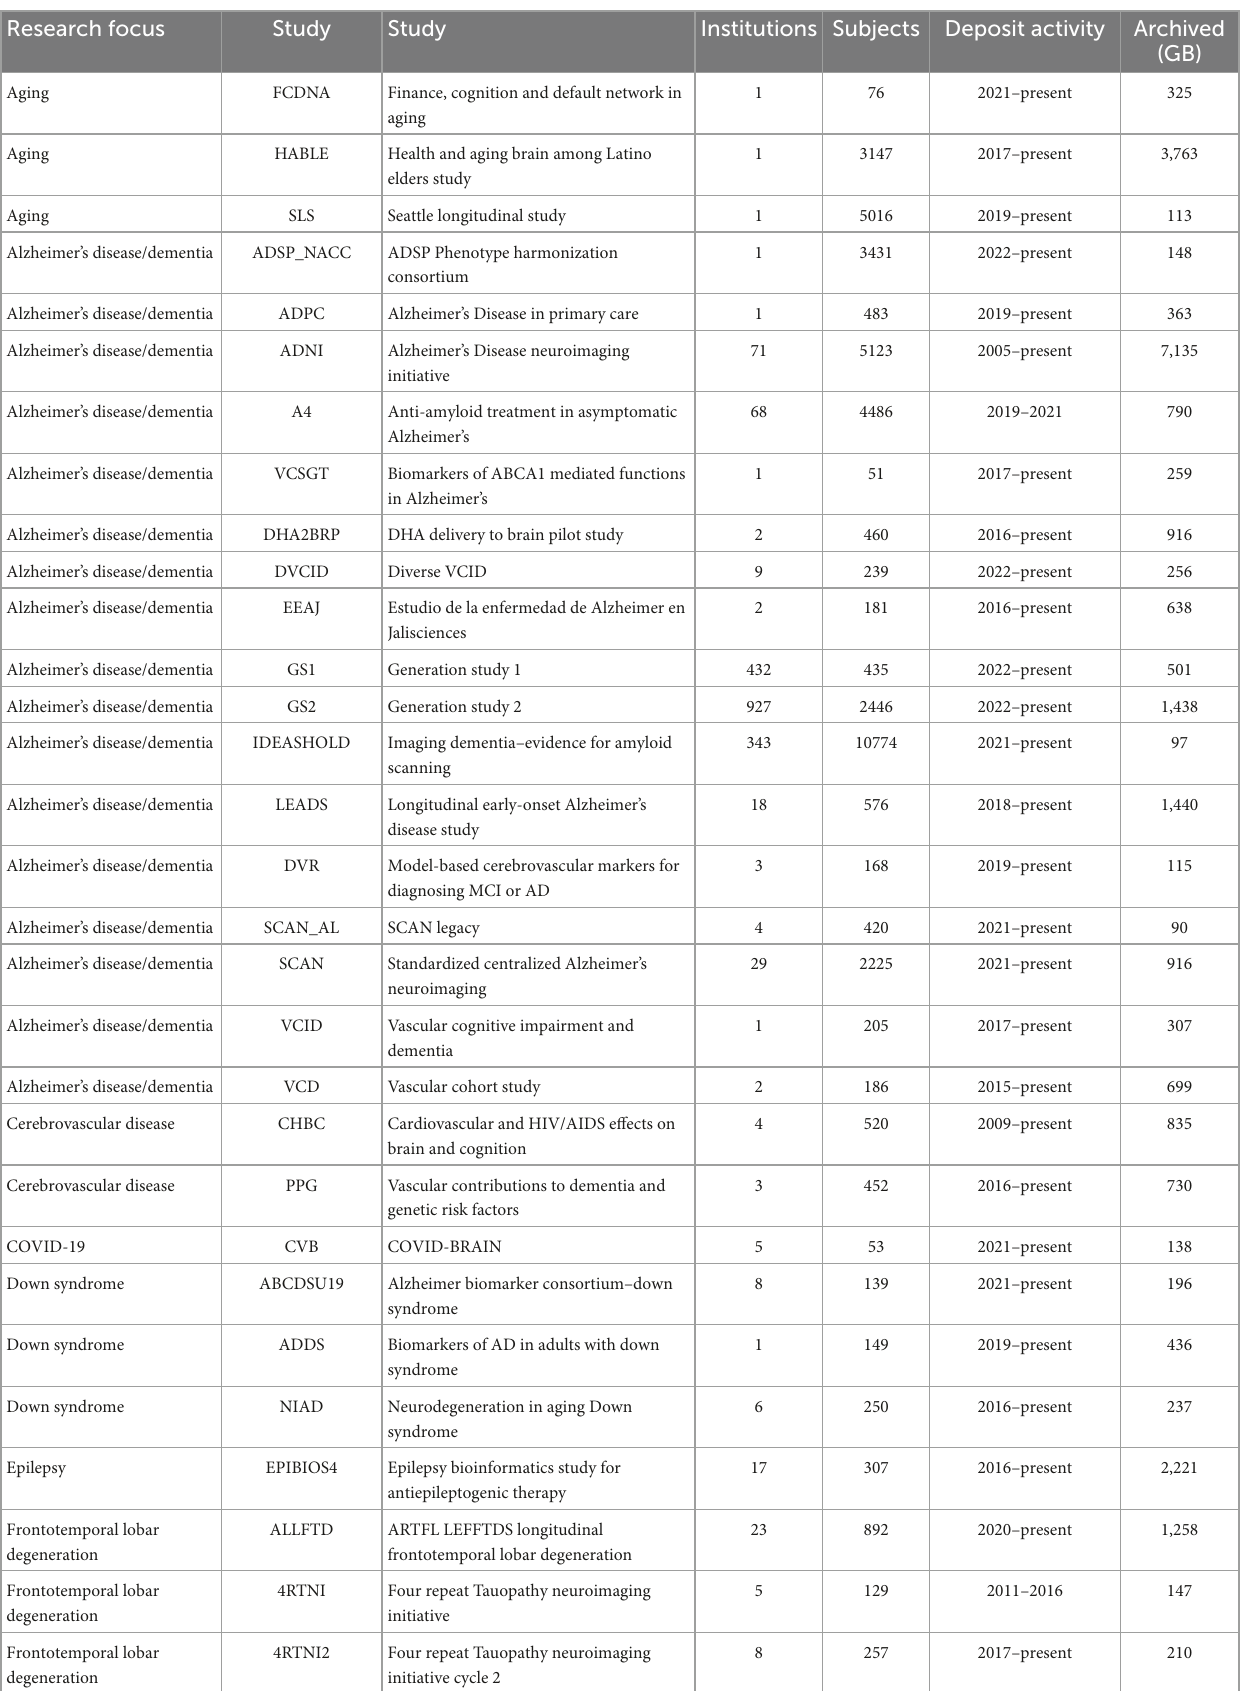
TABLE 1 Representative research studies utilizing the